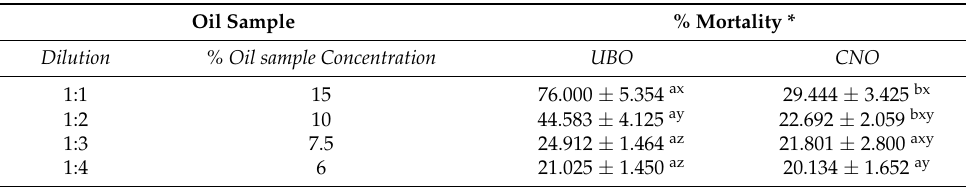
Table 7. The results obtained from the BSL assay after 6 h of A. salina larvae exposure, at different dilutions of UBO and CNO emulsions.